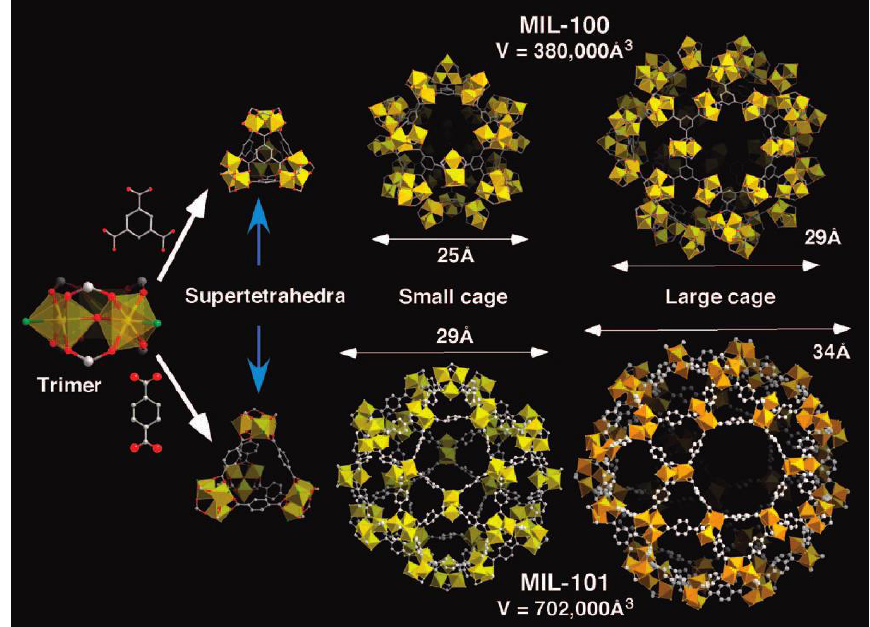
Figure 6. Structures of MIL-100 and MIL-101. Reproduced with permission from [67]. American Chemical Society, 2008.